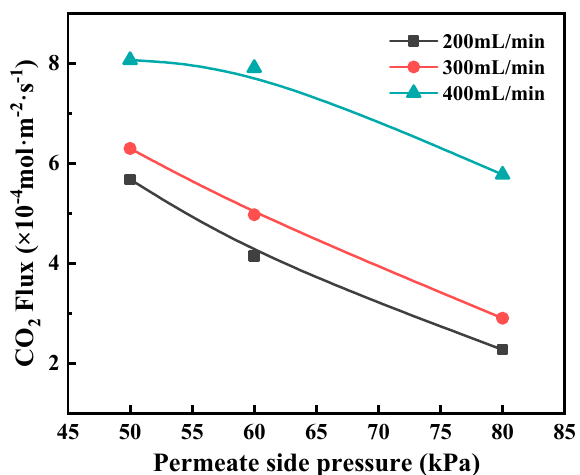
Figure 11. The effect of permeate pressure on CO 2 flux at different liquid flow rate. Experimental conditions: T = 373 K, C MEA = 5.0 mol/L, CO 2 loading = 0.45 mol CO 2 /mol monoethanolamine (MEA).